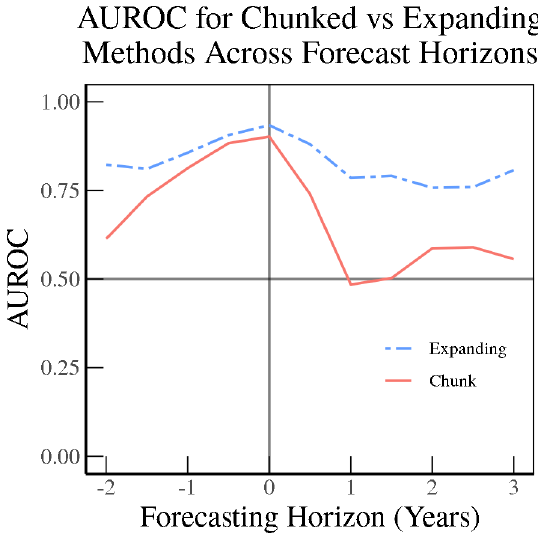
Figure 19. Results for R&R Minor Crises on OECD Text . Note: This figure shows the area under the ROC curve for the SVM Radial Model based on OECD text and Romer and Romer (2017) 5+ severity for backcast and forecast horizons of − 2 to 3 years (at half-year frequency) for the “chunk” for longer time horizons. The “expanding” method shows a more gradual decrease in model performance.